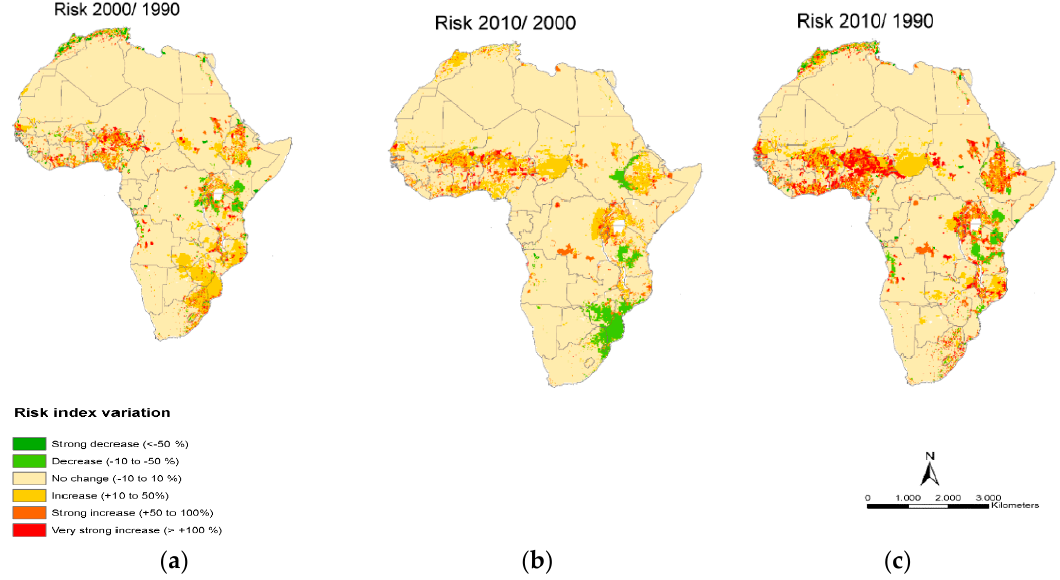
Figure 6. Relative comparison of groundwater pollution risk between ( a ) 2000 and 1990, ( b ) 2010 and 2000, and ( c ) 2010 and 1990 for the African continent.